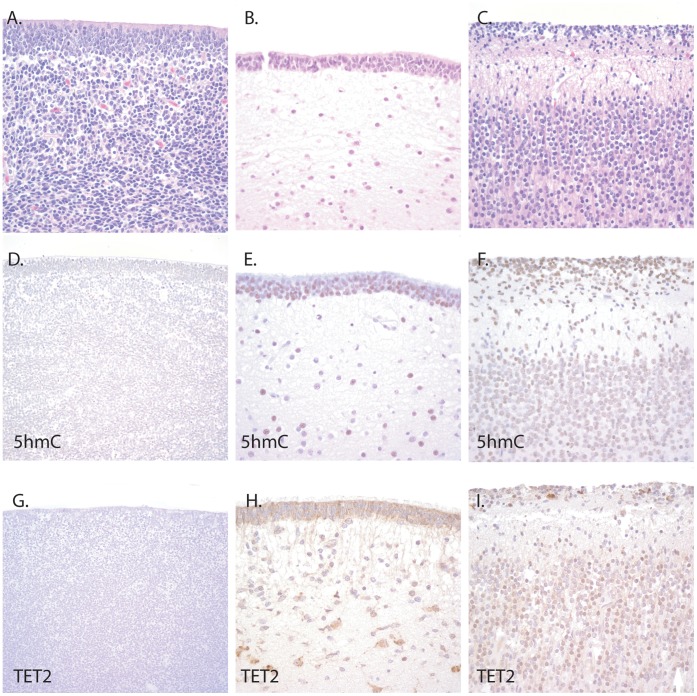
5hmC levels are reduced in the germinal regions of the human fetal forebrain.Fetal brain sections were stained with hematoxylin and eosin (A-C) and evaluated for 5hmC or TET2 levels using immunohistochemistry. Sections of the forebrain germinal region stained with antibodies for 5hmC (D) showed markedly reduced levels. In contrast, periventriclular regions outside the forebrain germinal matrix (E) and in the fetal cortex (F) showed high levels of 5hmC staining. TET2 immunohistochemistry (G-I) showed a similar distribution to 5hmC staining. Original magnification was 200X for all photomicrographs, except panels A, D, and G which were 100X.